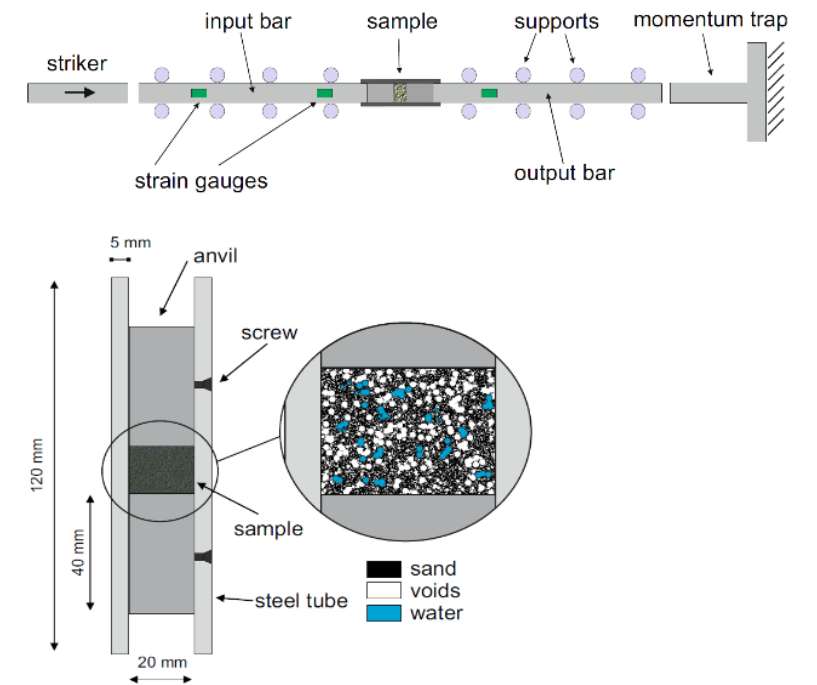
Figure 16. Split Hopkinson pressure bar system with soil specimen (reprinted from Ref. [81]).